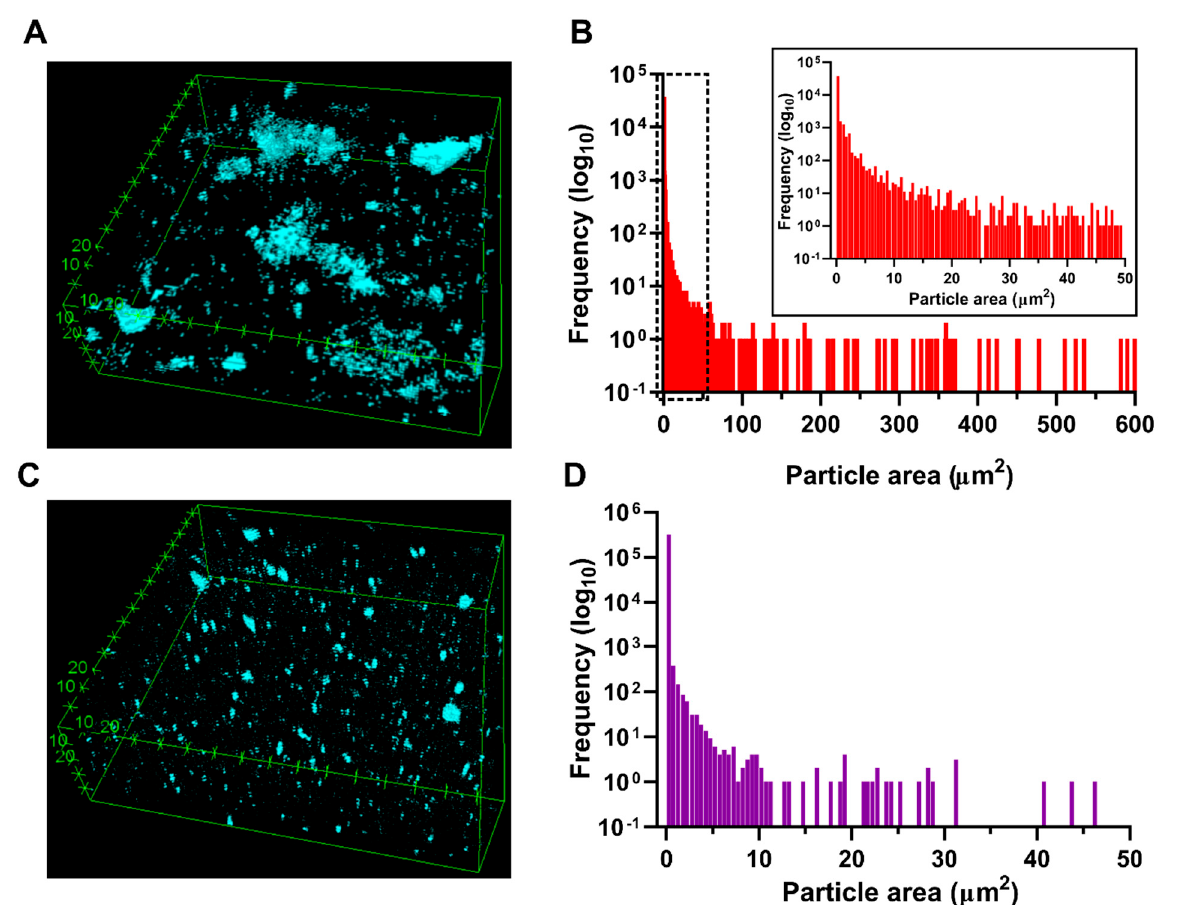
Figure 7. Dispersion of GO and morphological structure of the nanocomposite hydrogel. ( A ) Dispersion of serum-free GO in a ChiMA matrix. ( B ) Distribution of serum-free GO particle area, which shows proper tail distribution centered at 0.386 mm 2 . ( C ) Dispersion of serum-doped GO in a ChiMA matrix. ( D ) Distribution of serum-doped GO particle area, which shows proper tail distribution centered at 0.024 mm 2 .